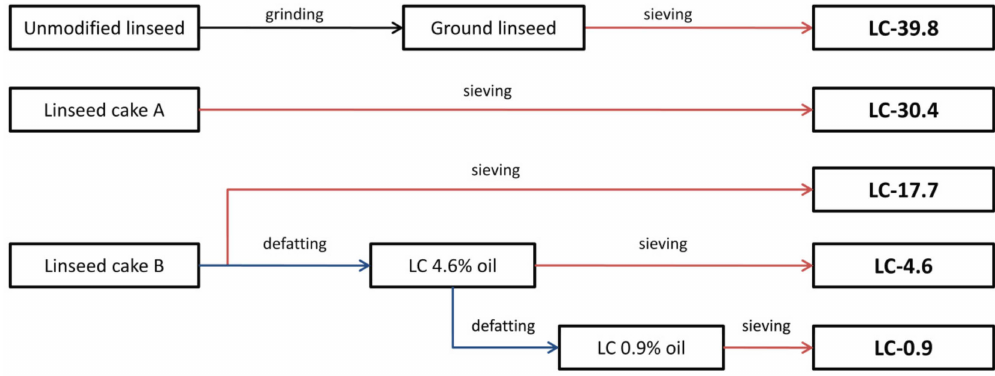
Figure 1. Schematic representation of the filler